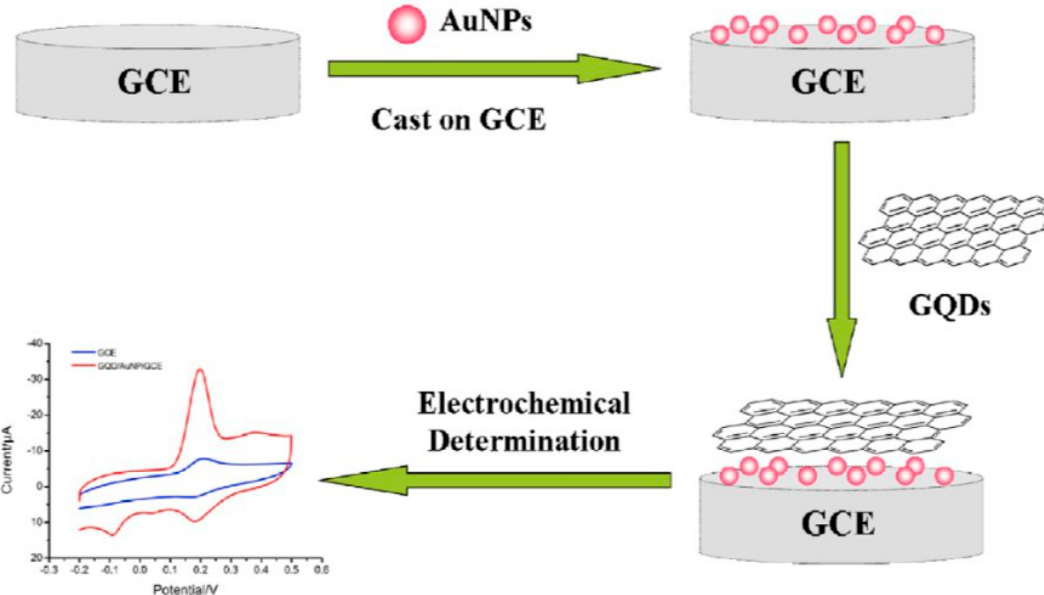
Scheme 9. Schematic illustration of the fabrication of GQD/Au NP/GCE and the electrochemical determination of quercetin. Reproduced with permission from ref. [101]. Copyright 2016, John Wiley & Sons.